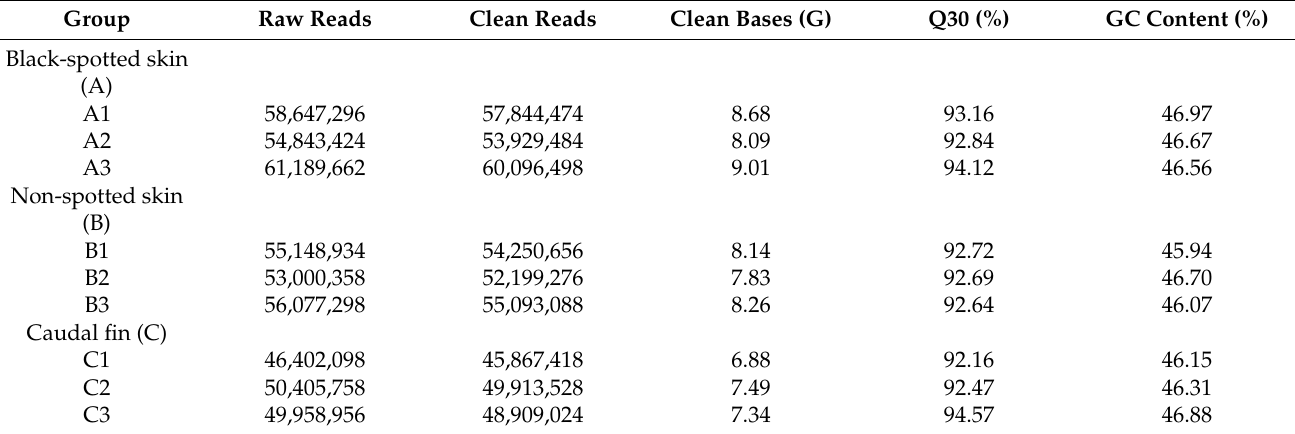
Table 1. Summary of the transcriptomic data from S. argus